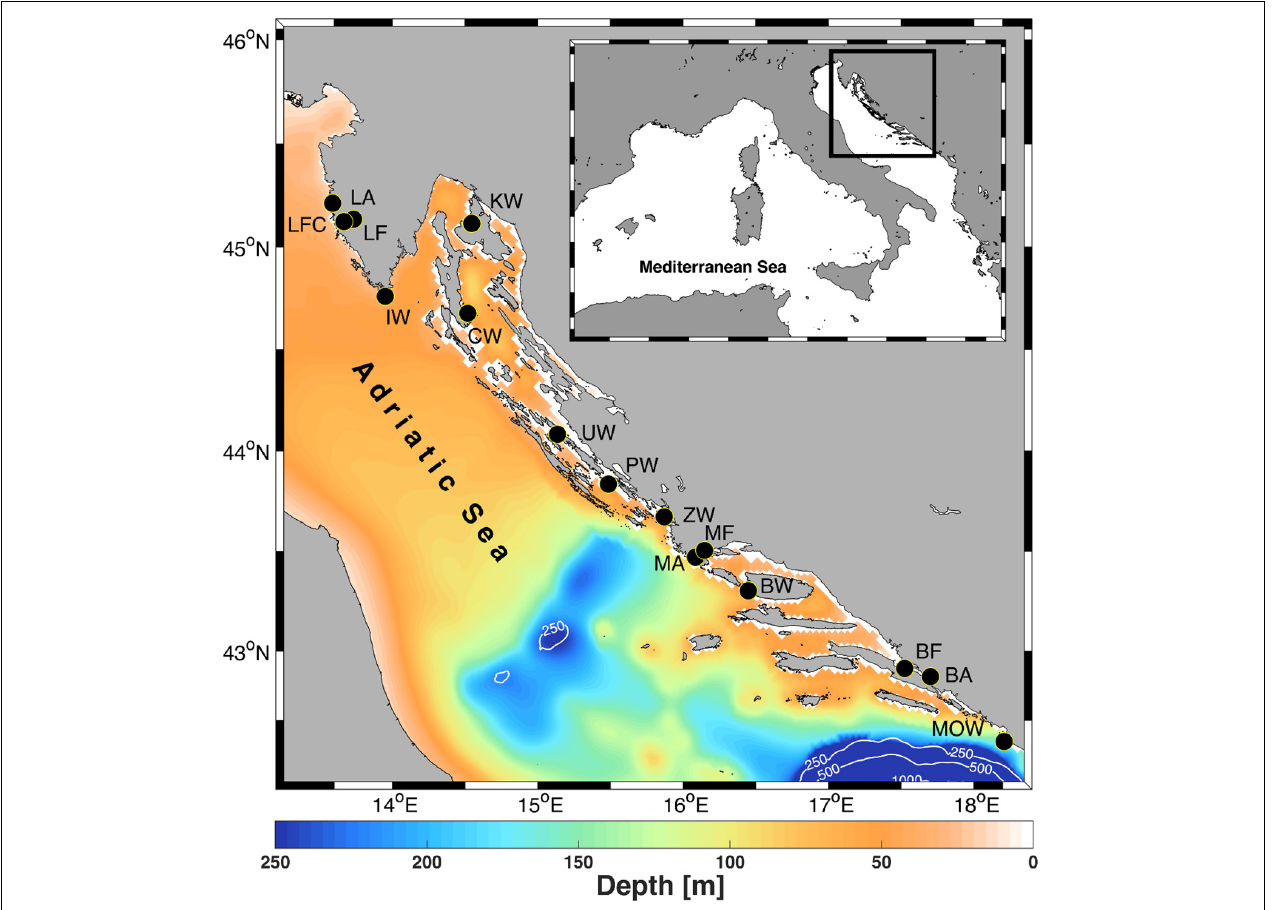
FIGURE 1 | Adriatic Sea bathymetry with sampling locations of wild European flat oyster (IW, Medulin; KW, Krk; CW, Cres; UW, Ugljan; PN, Pakoštane; ZW, Zeˇcevo; BW, Braˇc; MOW, Molunat), farmed (LF and LFC, Lim Bay; MF, Marina Bay; BF, Mali Ston Bay) and farm-associated adults (LA, Lim Bay; MA, Marina Bay; BA, Mali Ston Bay). Contours are drawn for 250, 500, and 1000 m depths. More information about population abbreviations and sampling years are provided in Table 1 . The figure has been created using MATLAB 2014a (www.mathworks.com) and GIMP 2.8.16 (www.gimp.org) software.